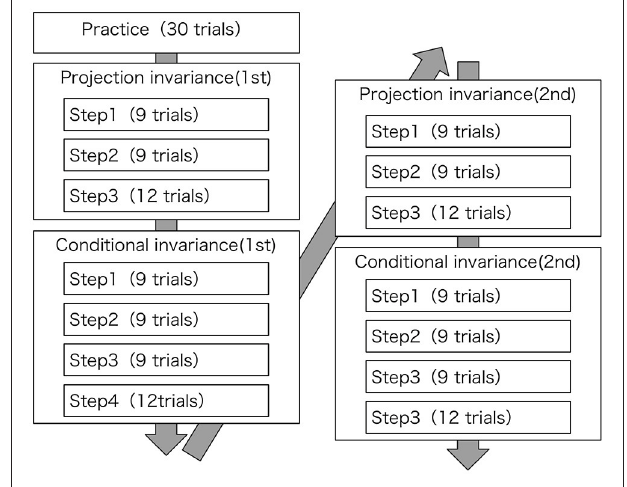
FIGURE 1 | Experimental process for testing axiomatic